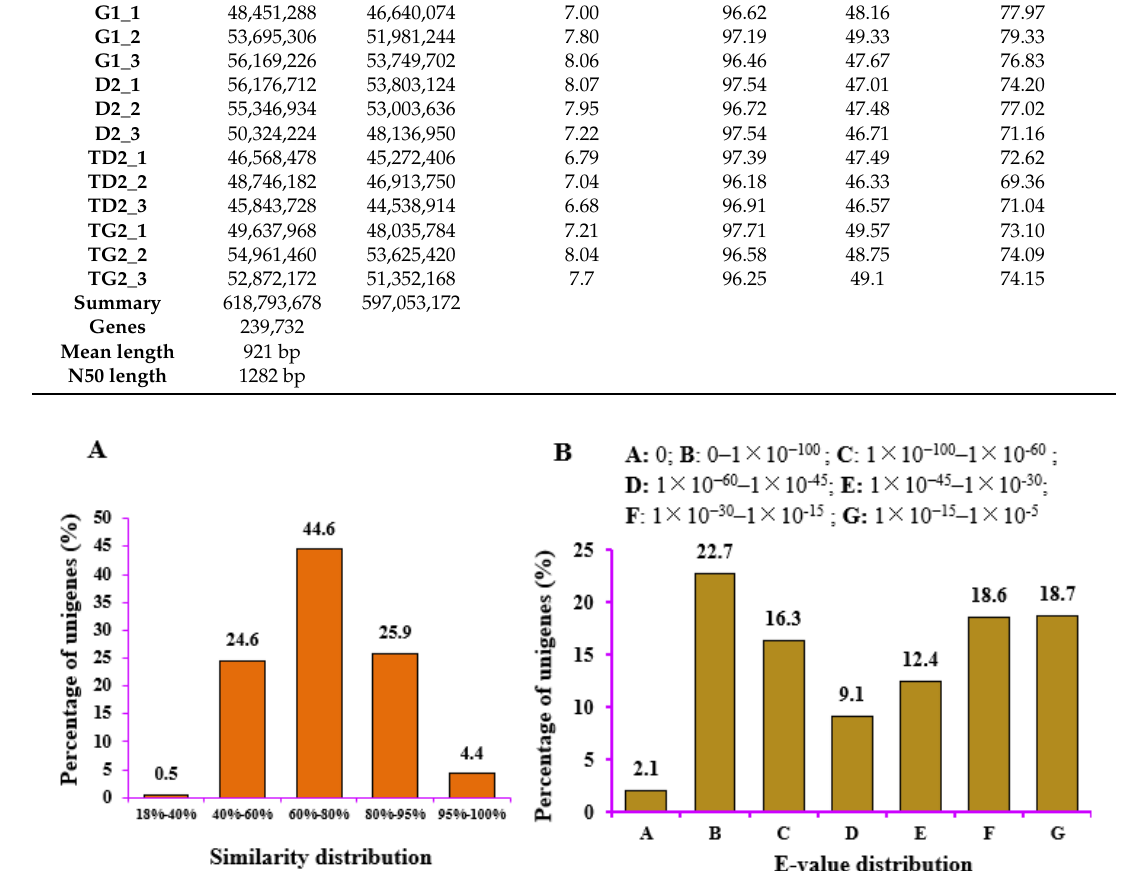
Figure 4. Characteristics of the similarity search of unigenes against the NR database: ( A ) similarity distribution of the top BLAST hit for each gene; and ( B ) E-value distribution of BLAST hits for each unigene with a cutoff E-value.